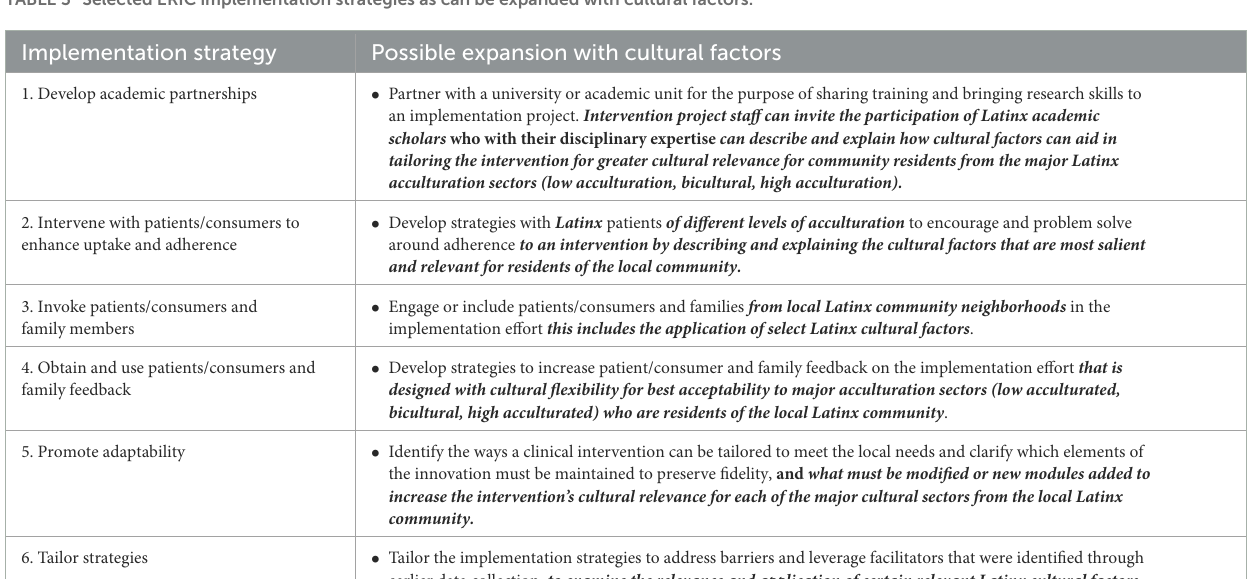
TABLE 3 Selected ERIC implementation strategies as can be expanded with cultural